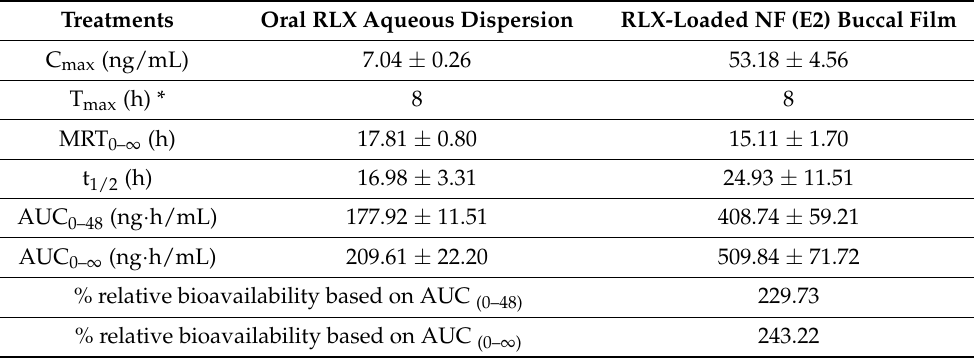
Table 2. The pharmacokinetic parameters and relative bioavailability of RLX following buccal application of RLX-loaded NF (E2) films and oral administration of RLX aqueous dispersion in rabbits (mean ± S.D., n = 6)